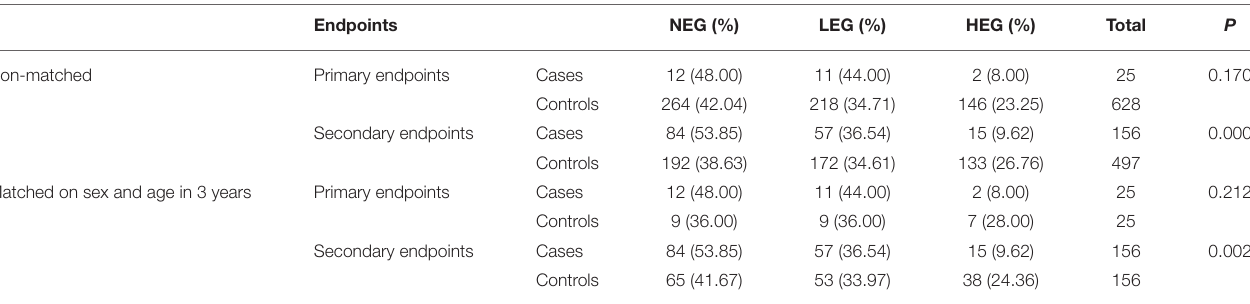
TABLE 4 | The results from the nested case–control